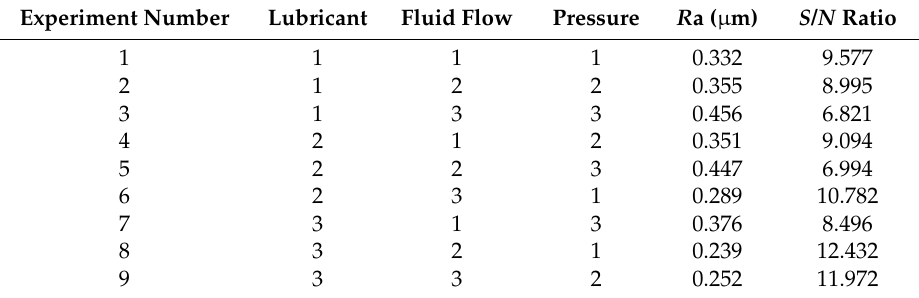
Table 4. The surface roughness result and S / N ratio.